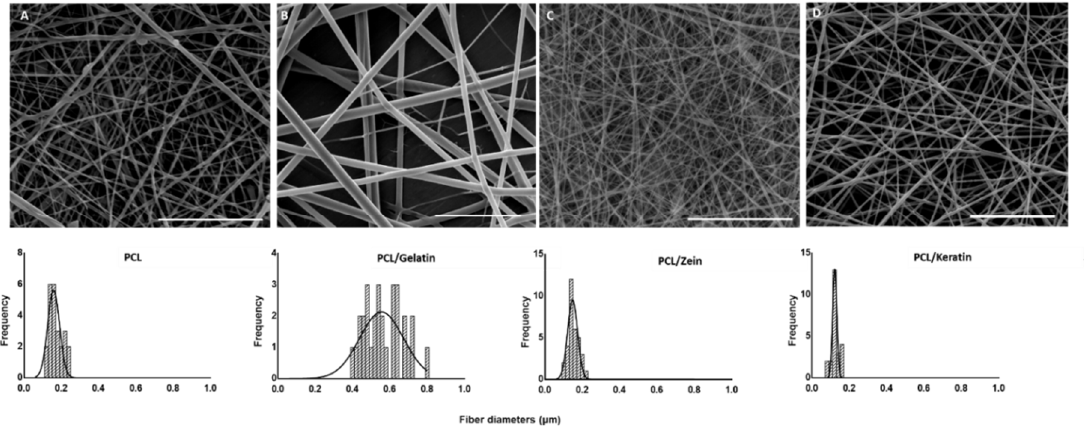
Figure 1. SEM images of PCL ( A ), PCL / gelatin ( B ), PCL / zein ( C ), and PCL / keratin ( D ) fibers (scale bar: 5 µ m) and fiber diameter distribution via image elaboration (bottom).